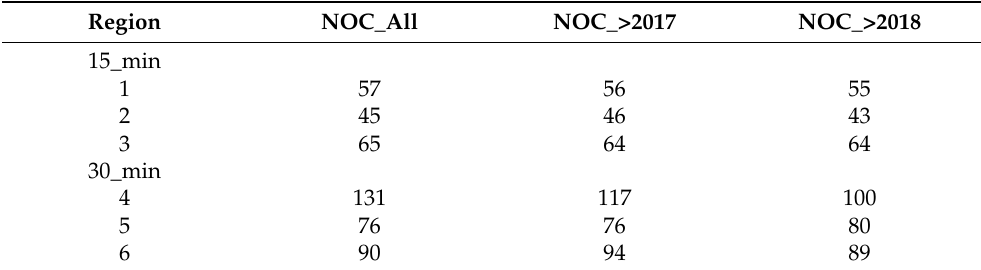
Table 5. Daily mean absolute error in minutes for the test sample of 2019 and 2020, using NOC models trained with different records.